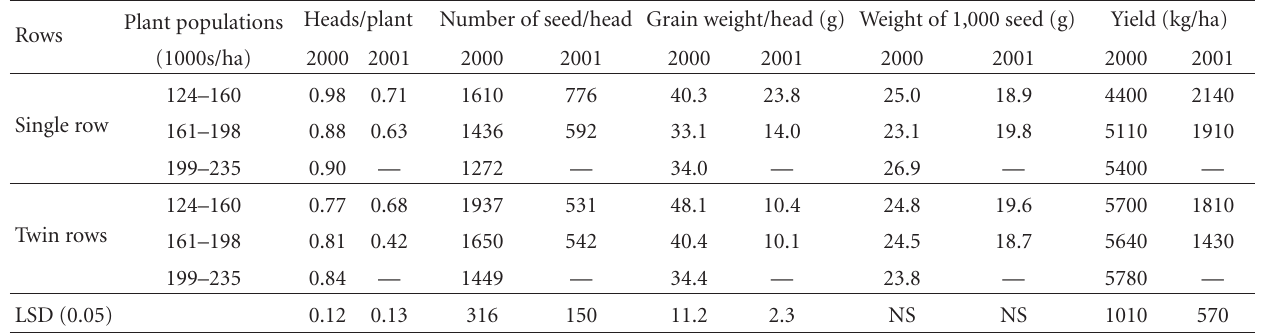
LSD (0.05) Table 3: Grain sorghum response to single and twin rows and plant populations under irrigated conditions in 2000. Rows Plant population (1000s/ha) Heads/plant Weight of 1,000 seed (g) Yield (kg/ha) Single row